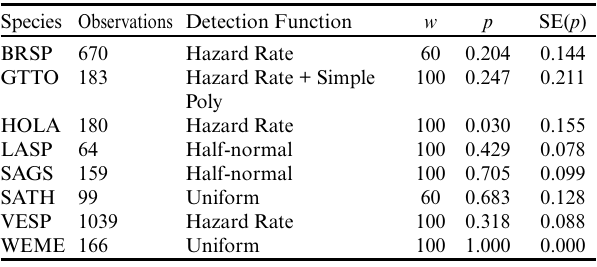
Table 1 . Numbers of birds detected, best fitting detection functions, truncation distance ( w ), detection probability ( p ), and